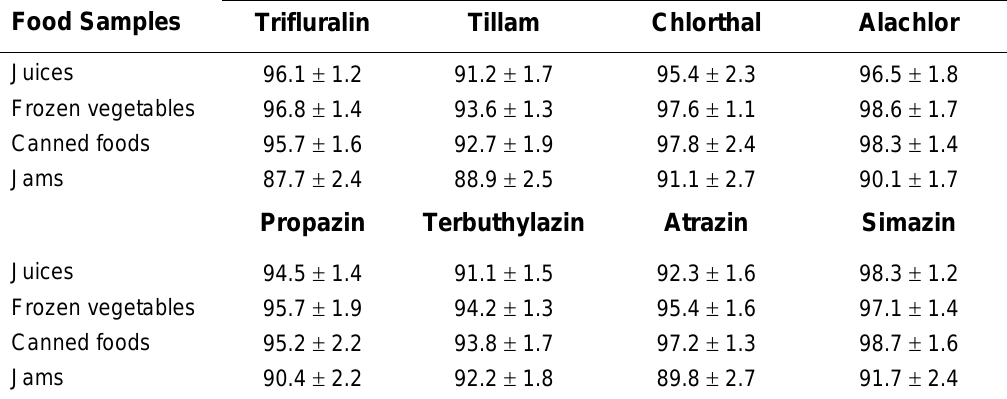
Herbicide Recovery and RSD Percentages of Spiked Food Samples Extracted by SFE and Determined by SFC/UVD at 220 nm Average Recovery and RSD% of Herbicides